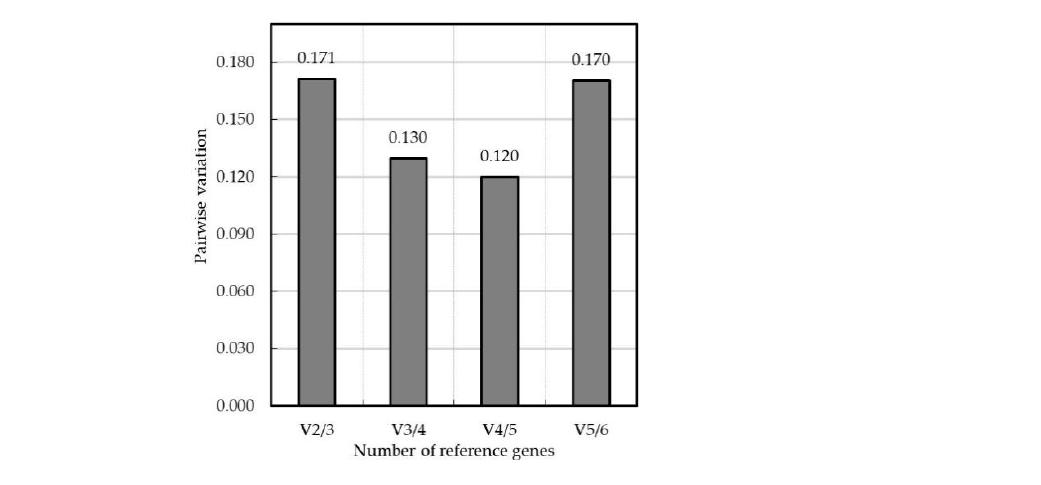
Figure 3. Determination of the number of reference genes by geNorm. The value of V 3/4 is smaller than the threshold 0.15 shows the most appropriate number of internal factors is 3.